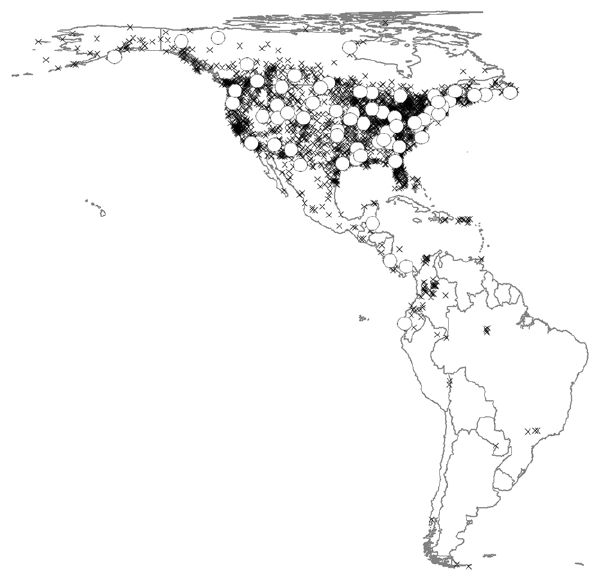
Figure 1. Sites with Christmas Bird Counts between 2000 and 2009. Black crosses are sites used in the generation of trait maps (n=2398), whereas white circles are sites used for evaluating the maps (n=68). In Behrmann cylindrical equal-area projection.